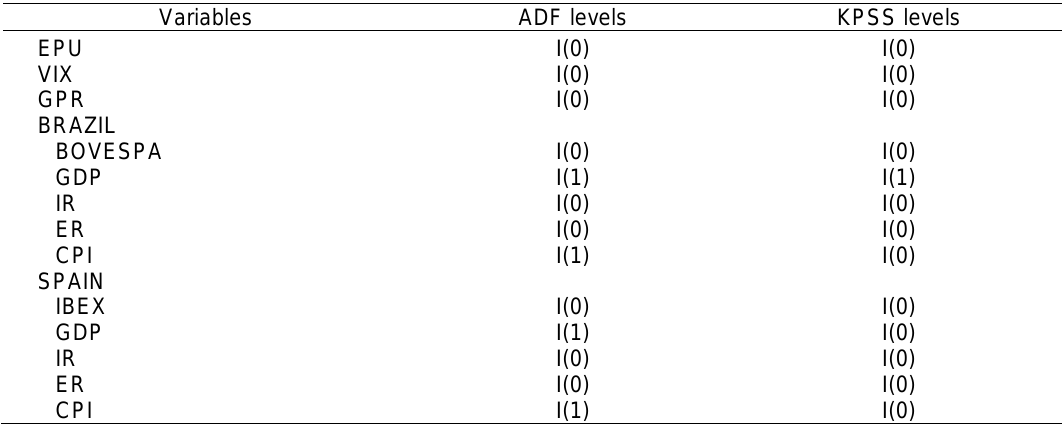
Table 2. Results of unit root tests. Variables ADF